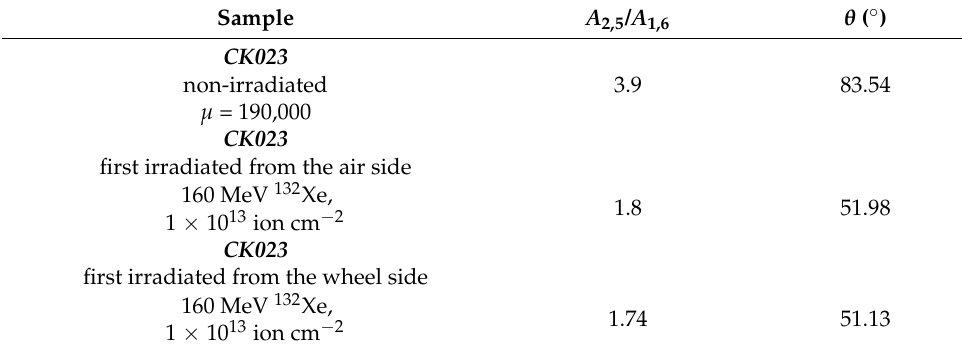
Table 2. Effect of swift heavy ion irradiation on the orientation of magnetization in the bulk FINEMET ribbons with high